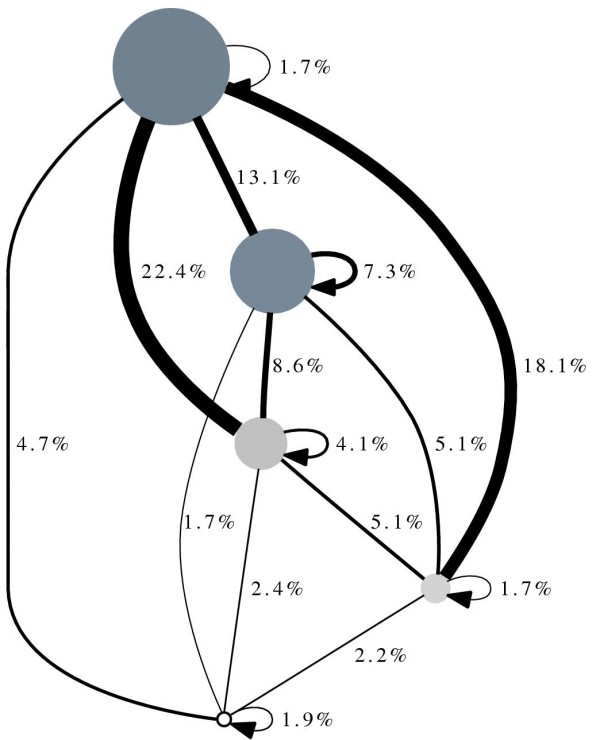
Network diagram. Figure 2 presents the diagram summarizing the protein interaction network as five groups of structurally similar proteins with interaction flows between them. The size and grey color intensity of the nodes reflect the degrees of proteins contained in each group. The width and labeling of the ties reflect the number of interactions between proteins belonging to two groups (demonstrated as percentage of the total network interactions). The arrows depict the self-interaction of each group.